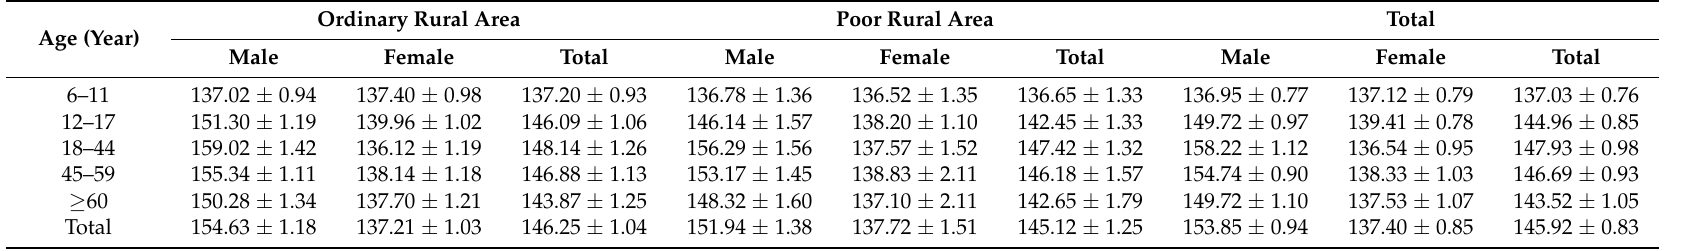
Table 4. 2010–2012 China’s rural residents’ hemoglobin levels (means ± standard deviation (SD), g/L).